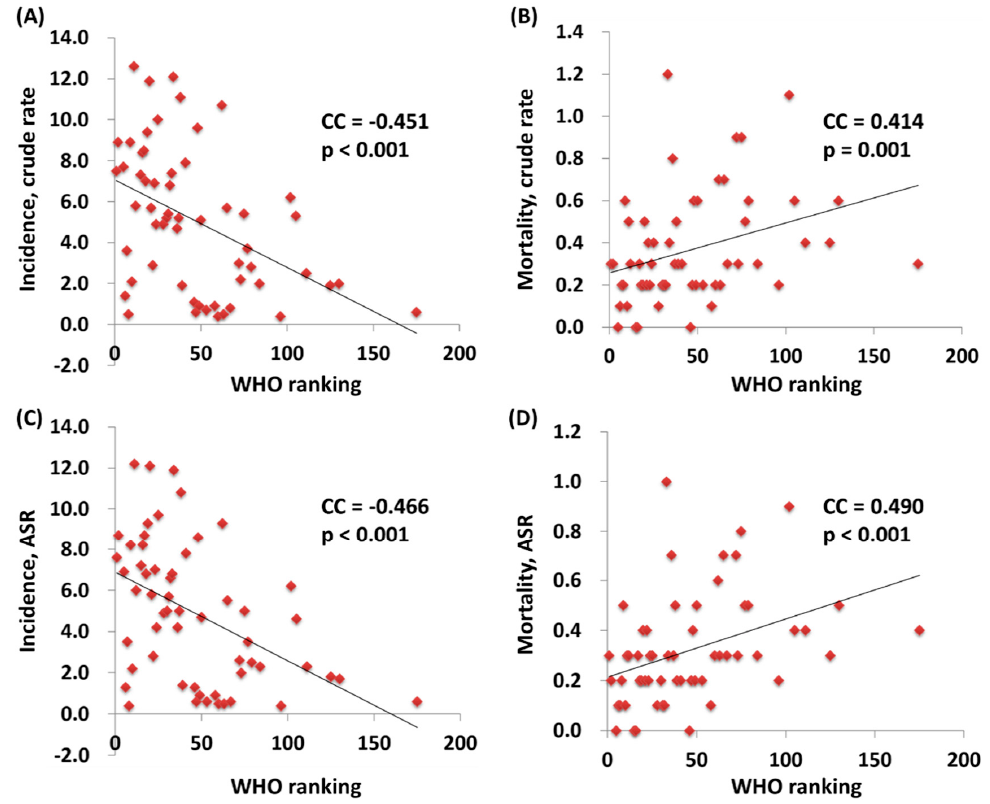
Figure 1. The association between the World Health Organization’s rankings and crude rates of ( A ) incidence and ( B ) mortality, and the ASR (age-standardized rate) of ( C ) incidence and ( D ) mortality.